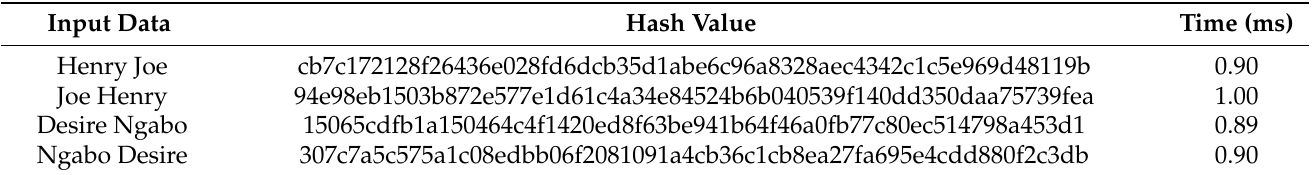
Table 2. The computation of the input message and hash result with